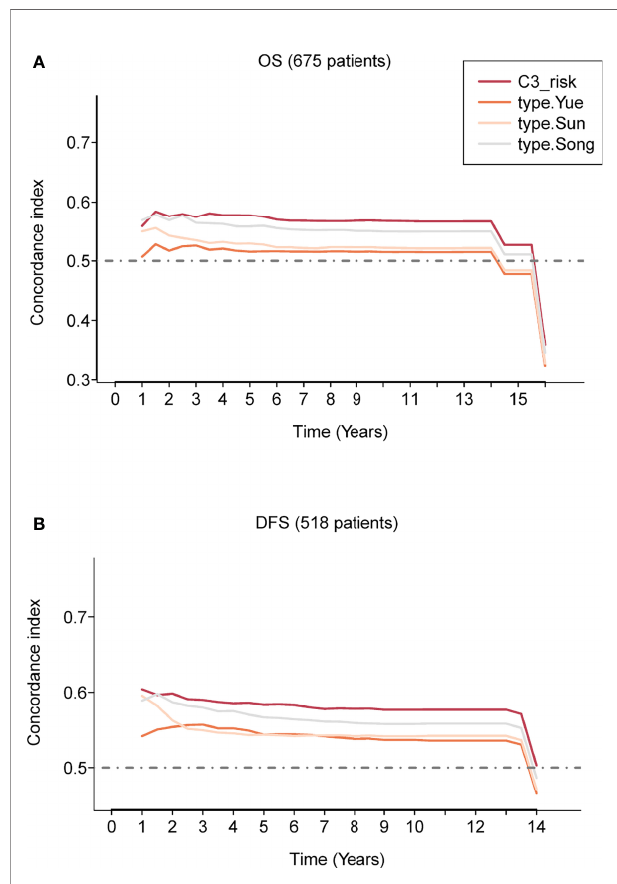
FIGURE 3 | Prognostic performance evaluation of the C3 IS. Concordance index showing a measure of concordance of the predictor with OS (A) and DFS (B) between C3 IS and three reported prognostic models in the combined three GEO cohorts ( n = 675).